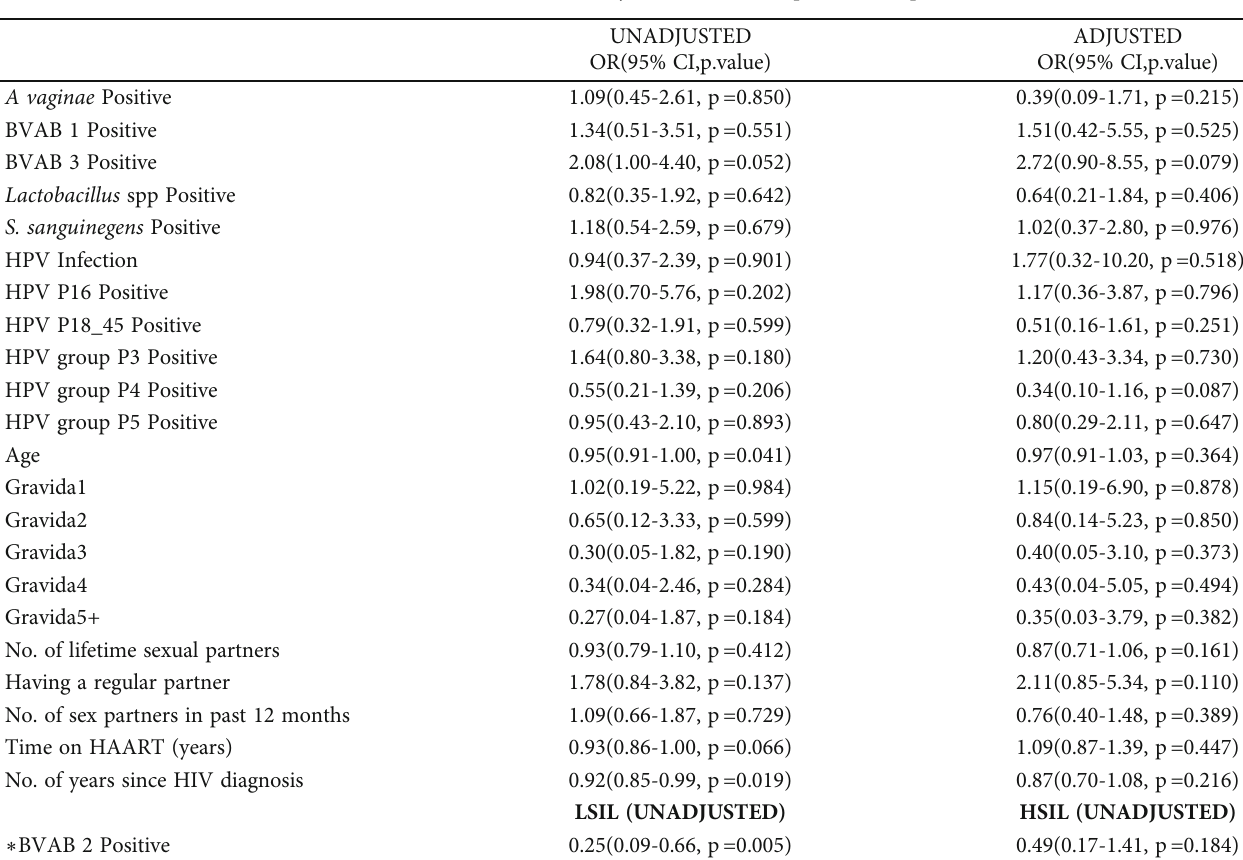
Table 3: Factors associated with the severity of Cervical Intraepithelial Neoplasia